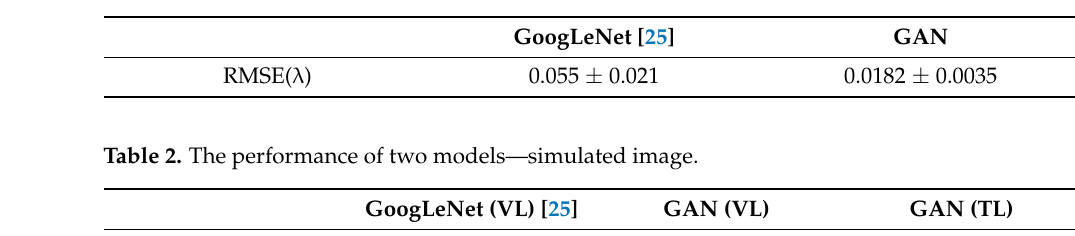
Table 1. The performance of two models—ideal image.